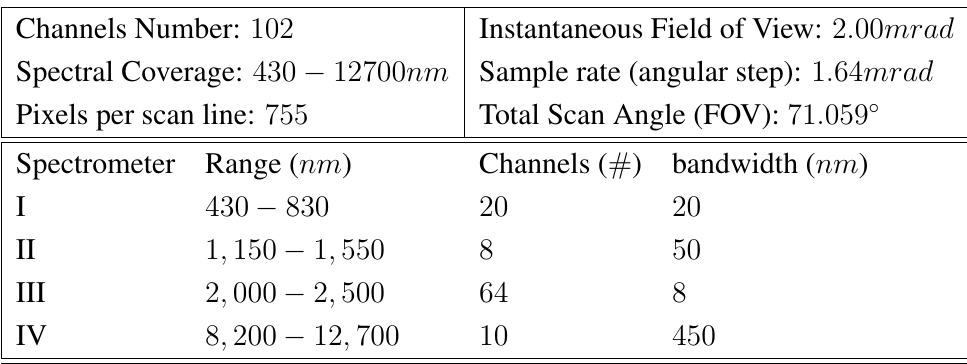
Table 1 . MIVIS sensor technical details and spectrometer characteristics.